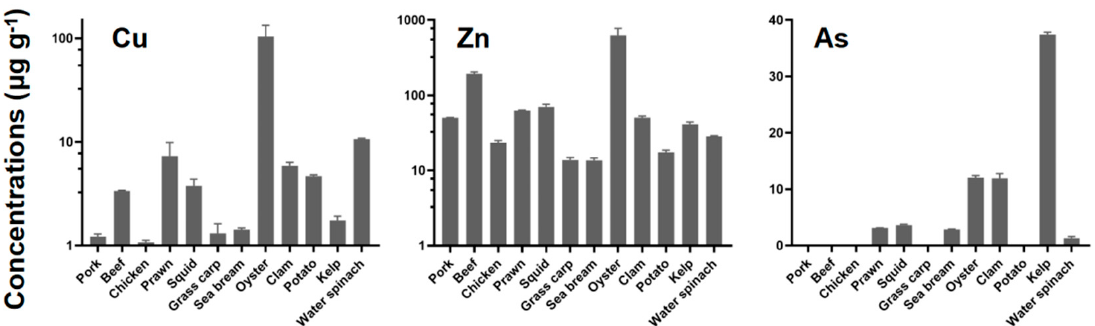
Figure 1. The concentrations (µg g − 1 , dry weight) of Cu, Zn, and As in the raw food ingredients. Data are expressed as means ± SD ( n = 3). Data are expressed as means ± SD ( n =